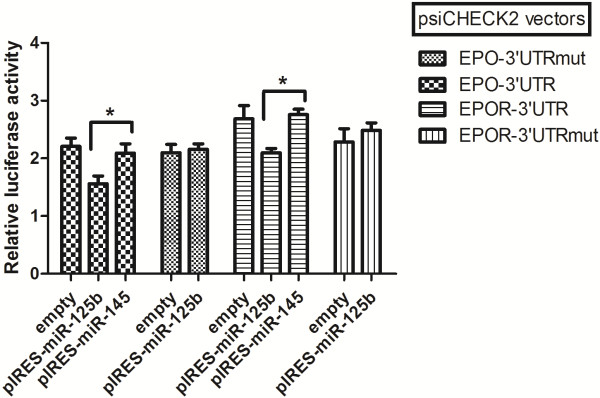
EPO and EPOR are targets of miR-125b. Luciferase reporter assays was performed with psiCHECK2 reporter vector after placing Renilla luciferase under the control of the EPO/EPOR 3′UTR. A not-targeting miRNA (miR-145), the empty pIRESneo2 vector and the mutated version of psiCHECK2 vectors were used as controls. The Renilla luciferase values were normalized for transfection with Firefly luciferase activity and data are presented relative to the vector control. The mean ± s.d. of three independent experiments in two different cell lines is shown. *P <0.05.